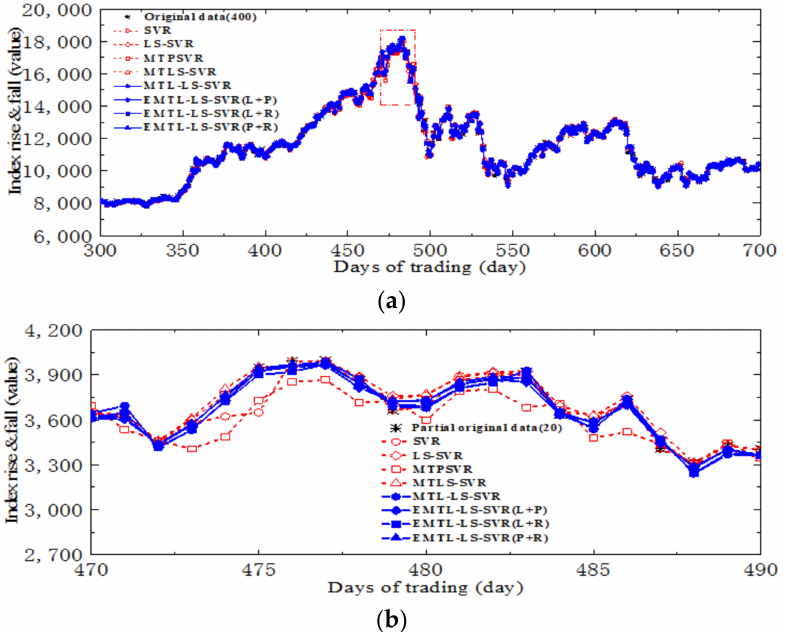
Figure 6. Predictions of different regression models on opening index for CNT ( a ) Original figure, ( b ) Enlarged